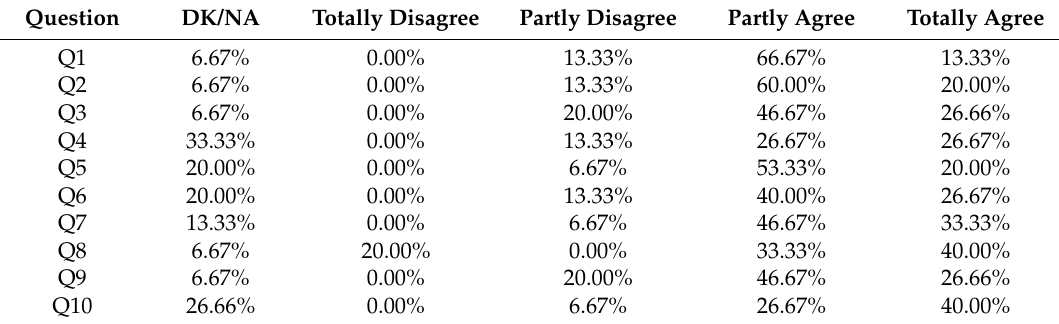
Table 2. Survey results per